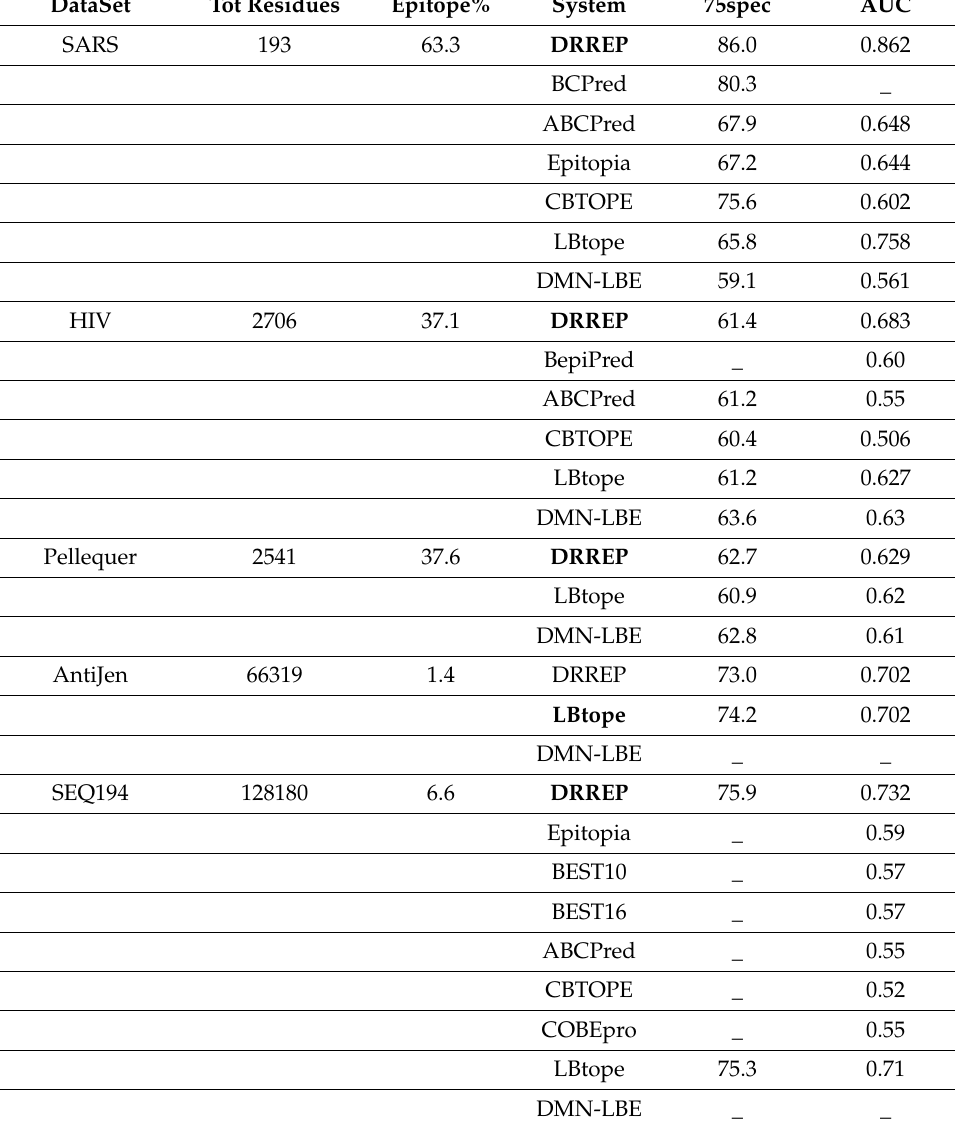
Table 1. Comparison of several linear B-cell epitope predictors across five di ff erent datasets. Results taken from